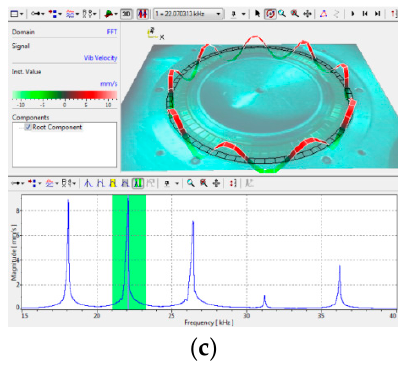
Figure 12. ( a ) PSV-300 scanning Doppler laser vibration measurement system; ( b ) measured mode of 70HA; and ( c ) measured mode of 70HB. Table 3. Vibration characteristics measurement of 70HA and 70HB.